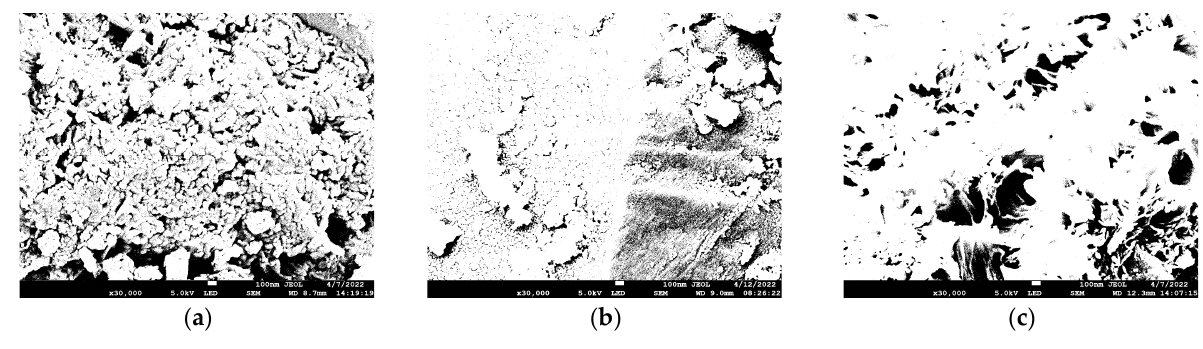
Figure 17. Microstructure diagram after the binarization process. ( a ) SRB-1. ( b ) SRG-1. ( c ) SRL-1.